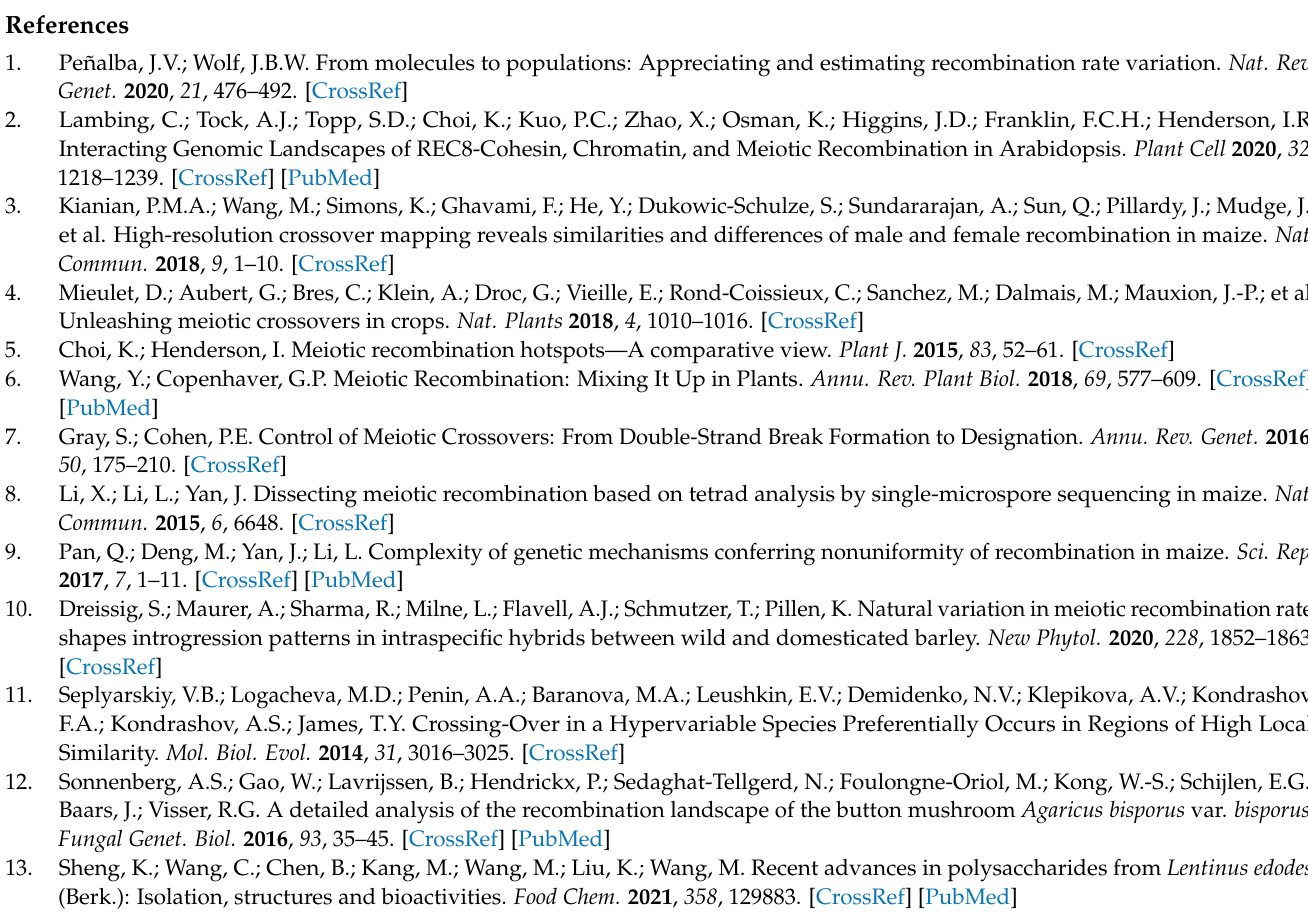
110 single spore isolates. Table S2: Table S2. Crossovers and lengths of nine chromosomes in L. edodes . Table S3: Distribution of crossover hotspot regions in L. edodes genome. Table S4: Associations of corssovers and genes regulating fruiting body-related traits. Table S5: Genes in confidence interval of QTLs for crossover variation in L.edodes . Supplementary File S1: